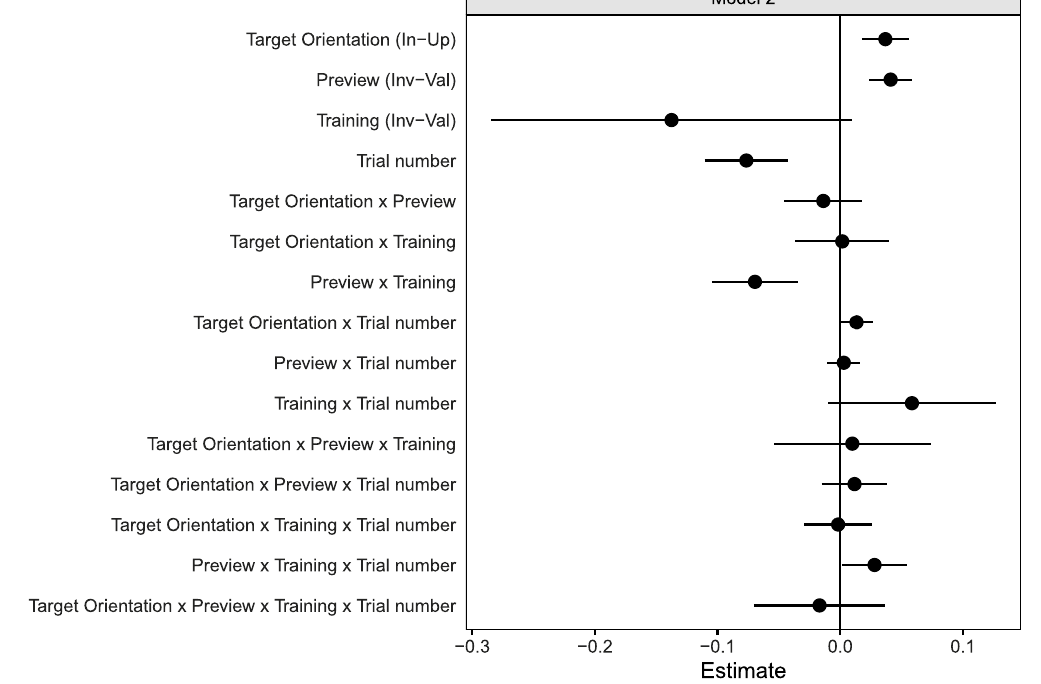
Figure 3. Fixed effect coefficients of the maximum identified linear mixed model on response times (Model 2). Error bars represent 95% profile confidence intervals. Effect contrasts for each factor are given in brackets next to the names of main effects on the y-axis. In-Up Inverted minus upright, Inv-Val Invalid minus valid. For example, a positive estimate for the Preview effect (invalid minus valid) means that responses were slower for invalid than for valid trials.